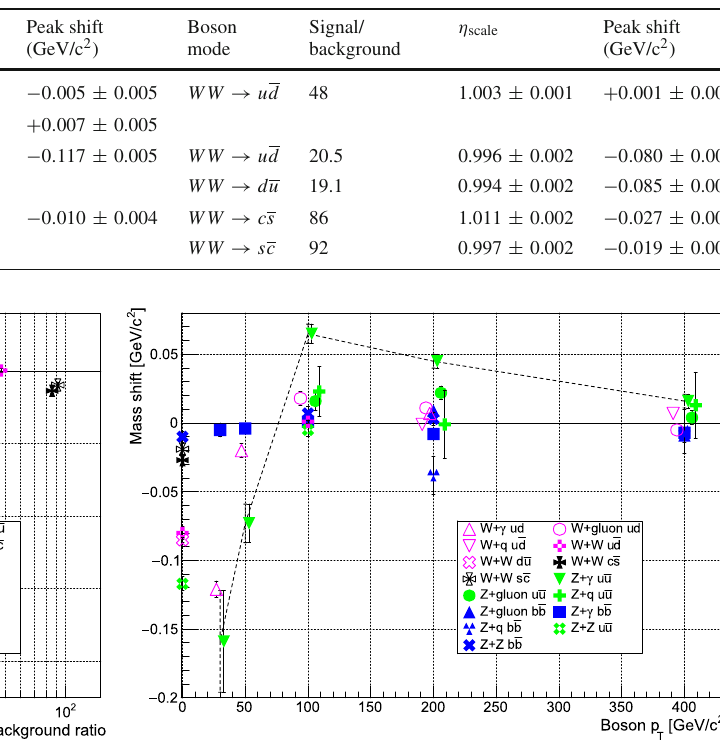
modes. Right shows hadronic vector boson recoiling against q , gluon, γ , W or Z , as a function of the p → uu , T of the vector boson. For the Z a dashed line links the different p T